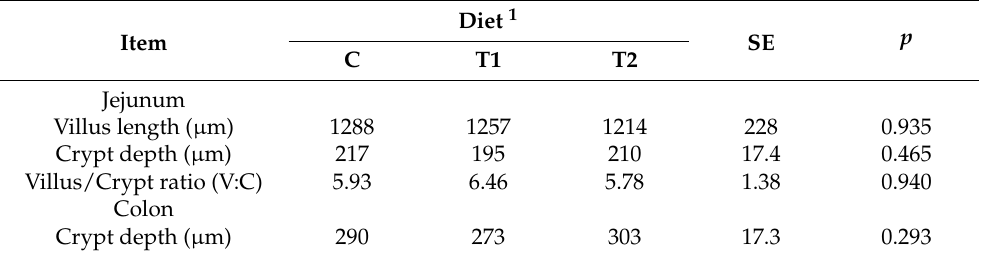
Table 5. Analysis of the effect of dietary treatment on intestinal microbial composition. Data are given as means per treatment and expressed as (Log 10 n)/g DM.